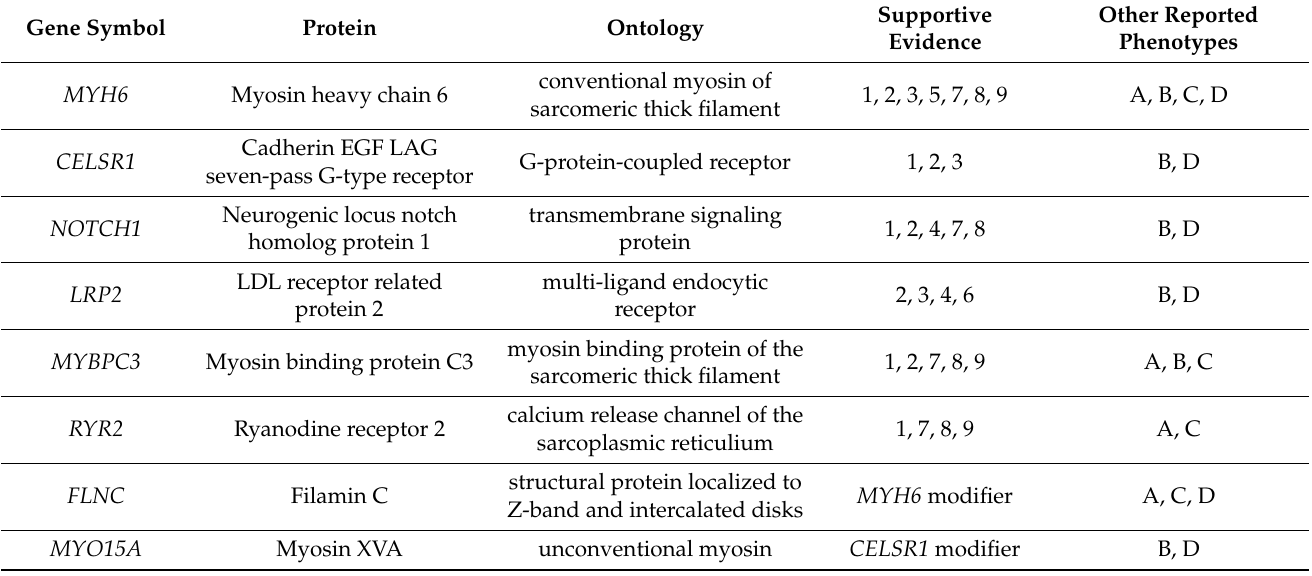
Table 2. HLHS-susceptibility